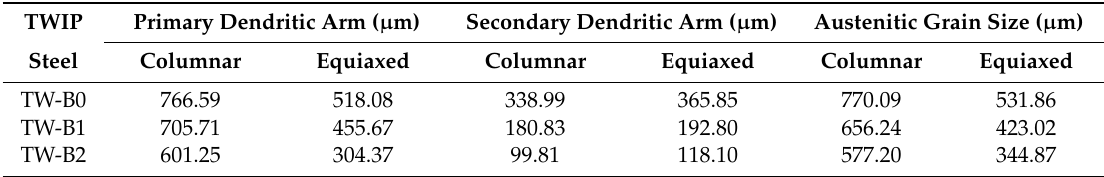
Table 2. Average values of measured primary and secondary dendritic arm length and austenitic grain size. TWIP Primary Dendritic Arm ( µ